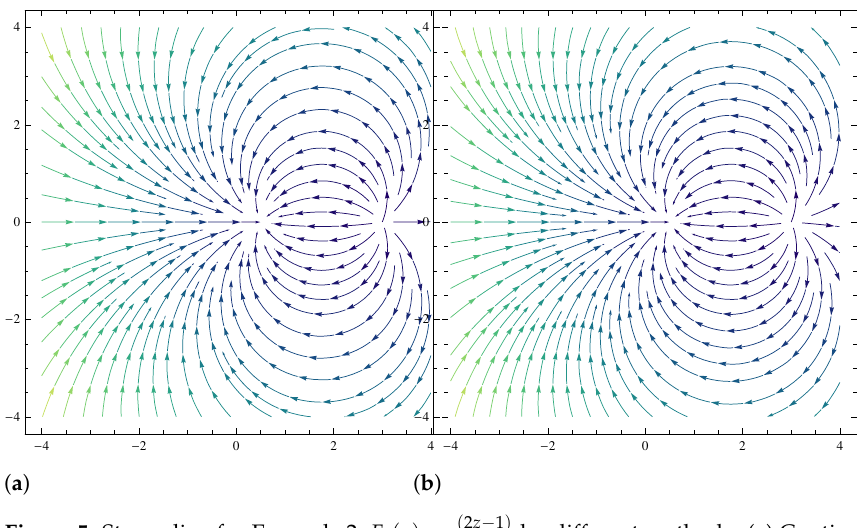
by different methods. ( a ) Continuous Newton ( z − 3 )